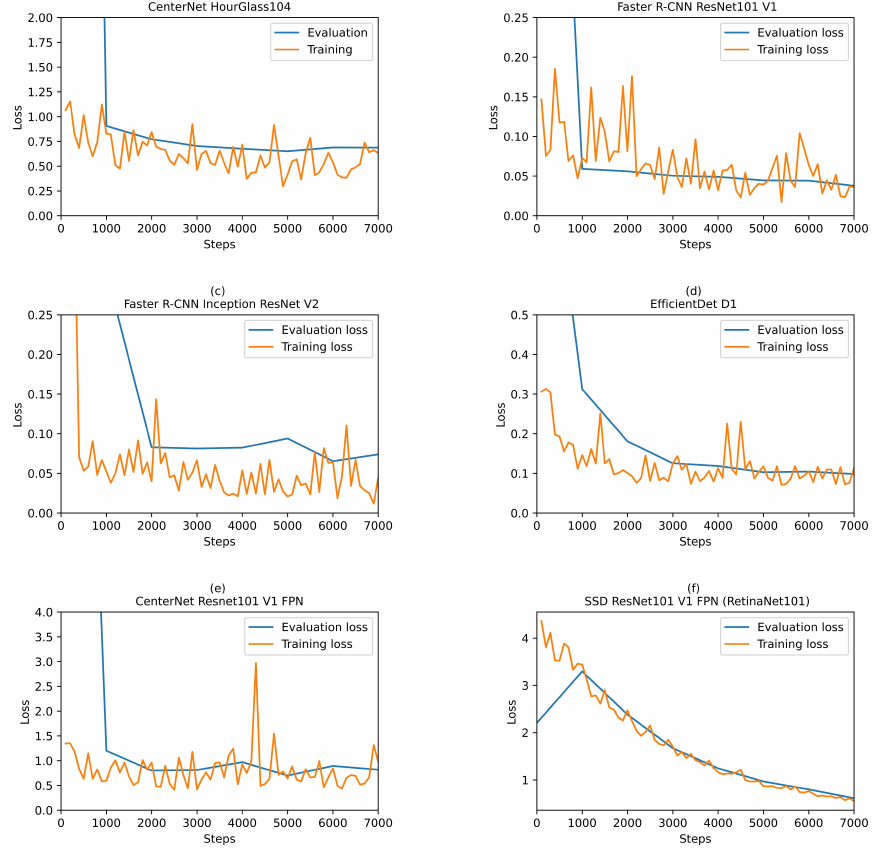
Figure A1. Evaluation and training loss functions of the CNN models